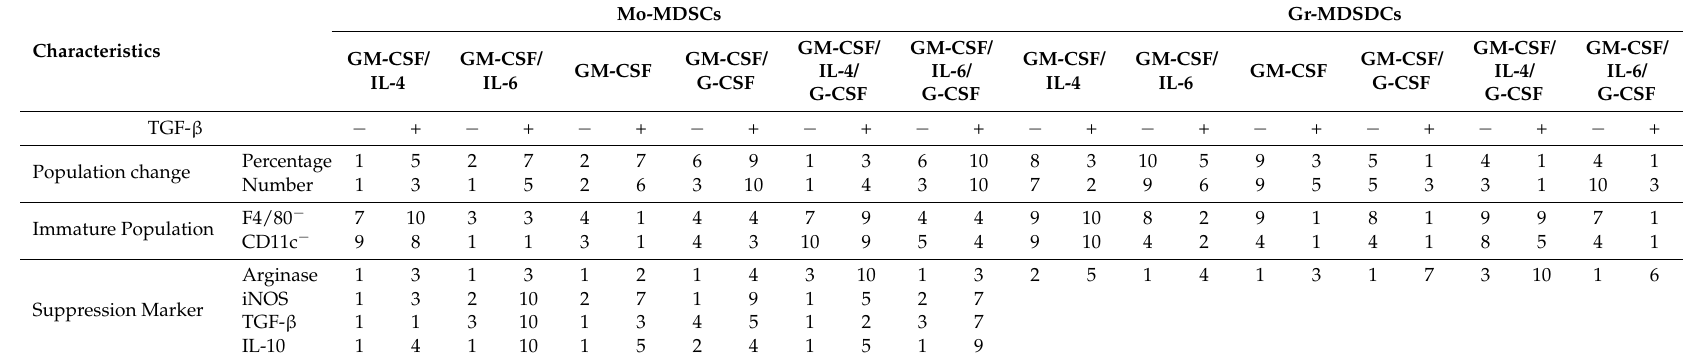
Table 1. Summary of MDSCs characteristics induced with six cytokine combinations with or without TGF- β